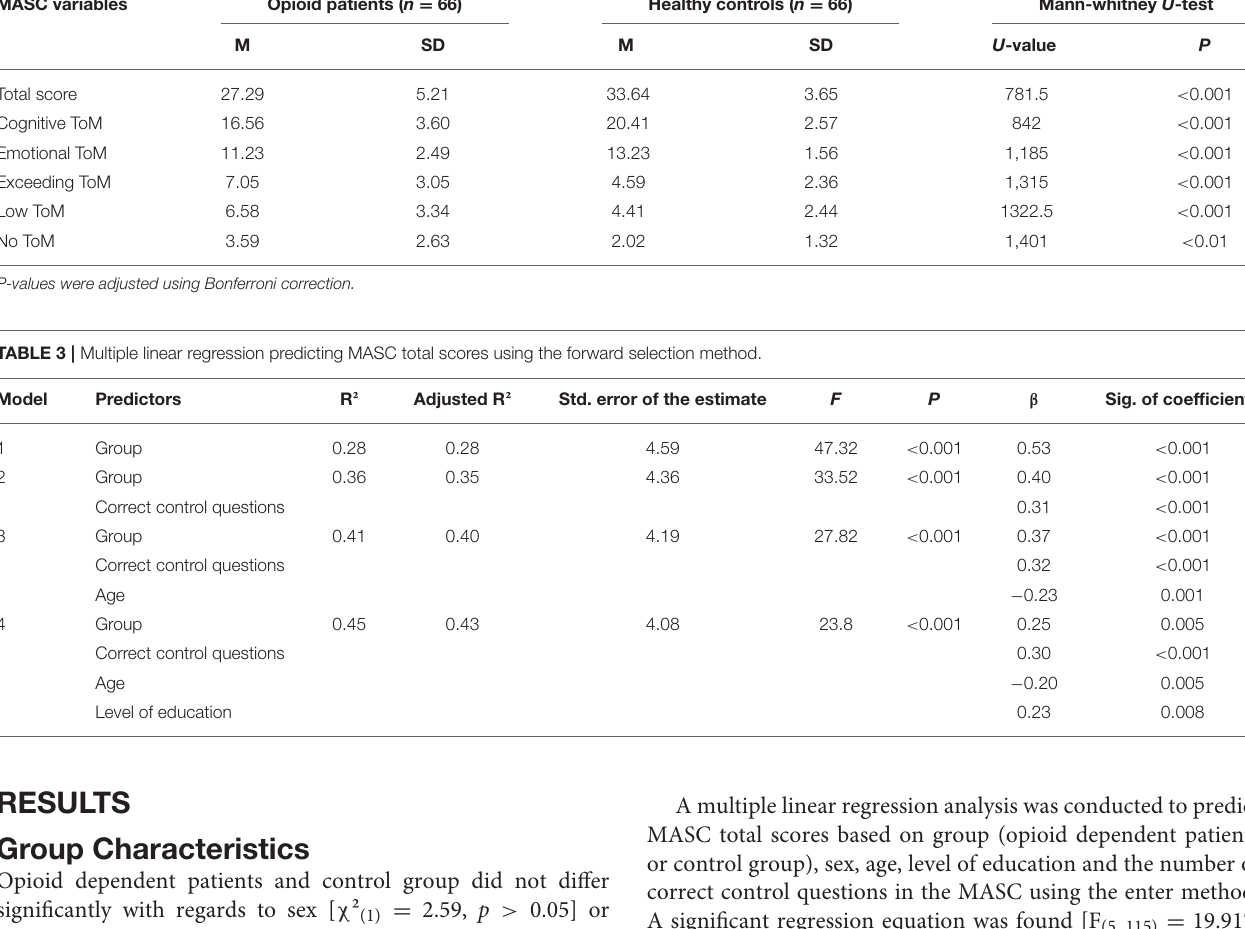
TABLE 2 | Descriptive statistics for MASC scores in opioid dependent patients and control group and group comparison with Mann-Whitney U -test. MASC variables